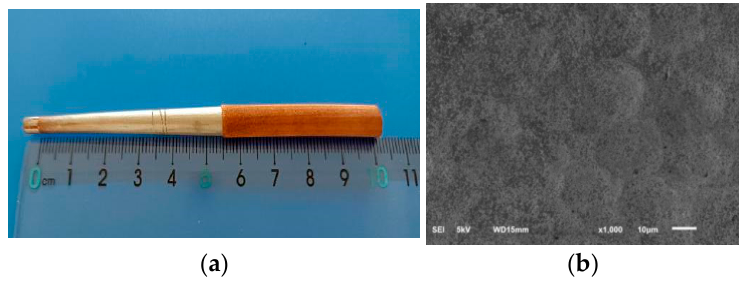
Figure 2. Experimental results of the sample with pyrophosphoric acid solution. ( a ) morphology of the sample, ( b ) SEM image of copper layer on sample